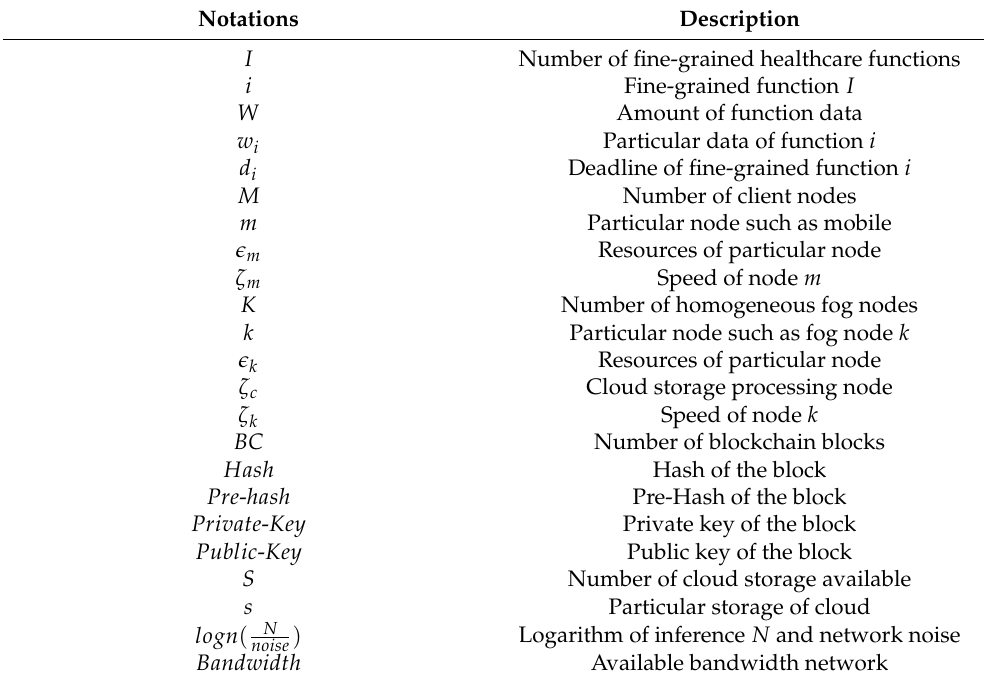
Table 2. Problem Constraints and